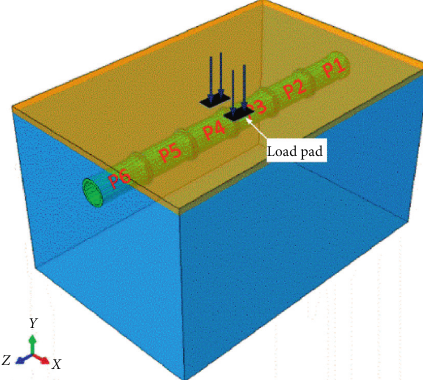
Figure 4: The location of the traffic load.